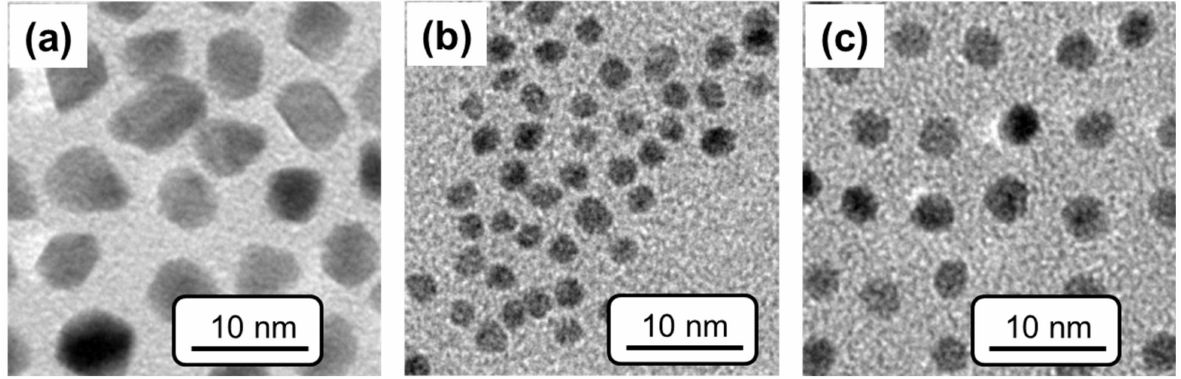
Figure 5. High magnification TEM images of: ( a ) M-PtNPs; ( b ) D-PtNPs; ( c ) T-PtNPs, synthesized at 200 ◦